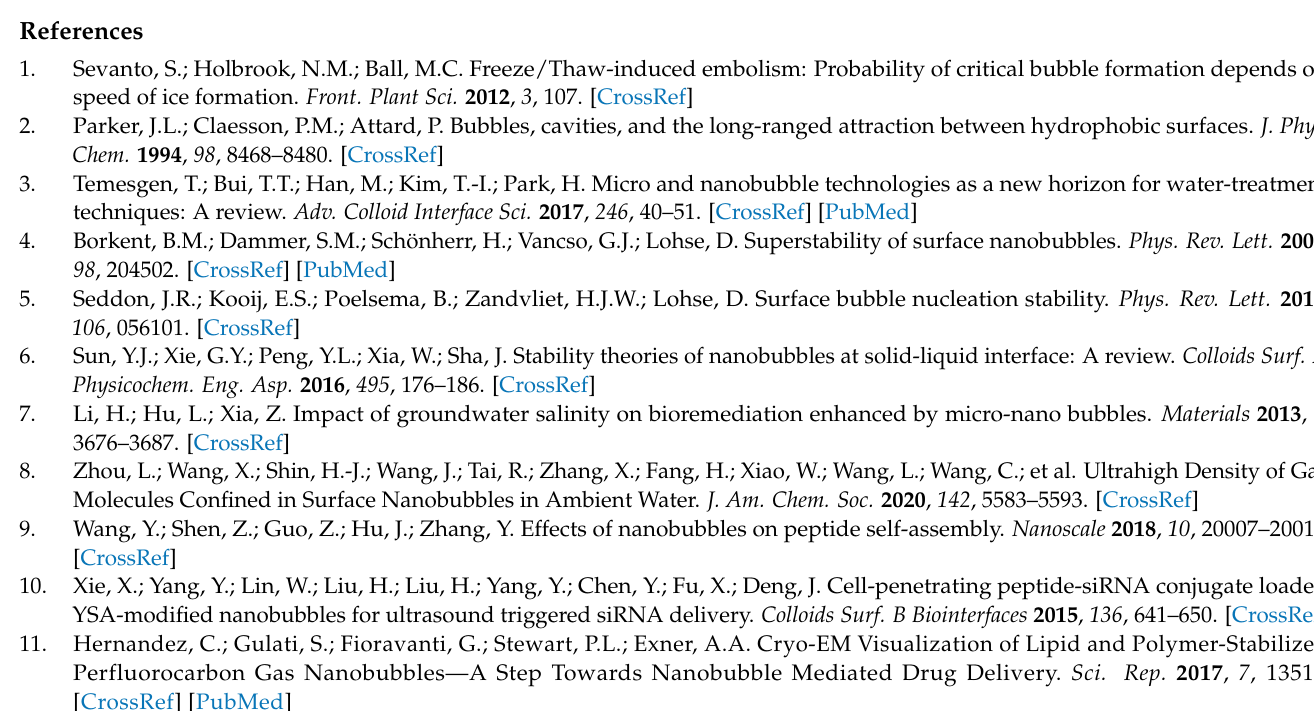
Figure S1: Zeta potential distribution of different types of water; Figure S2: Evidence for BNBs adsorbed on food surfaces; Figure S3: The size distribution of nanobubbles under different